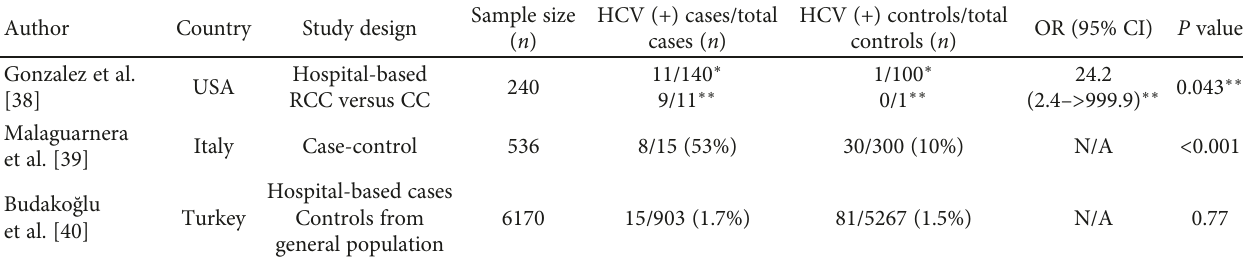
Table 5: Case-control studies for association of chronic HCV infection with renal cancer (RC).